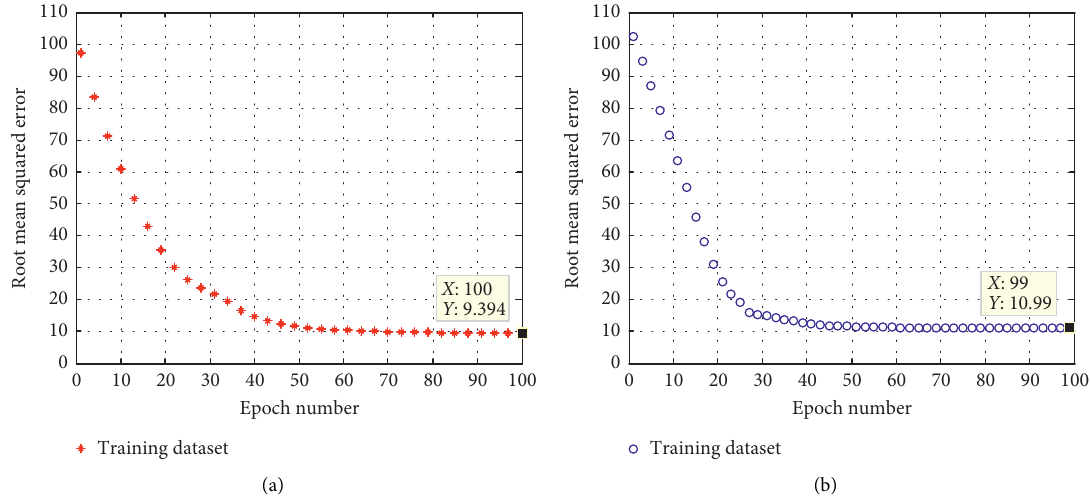
Figure 8: Error accumulation of the ANFIS model. (a) Training. (b) Testing.